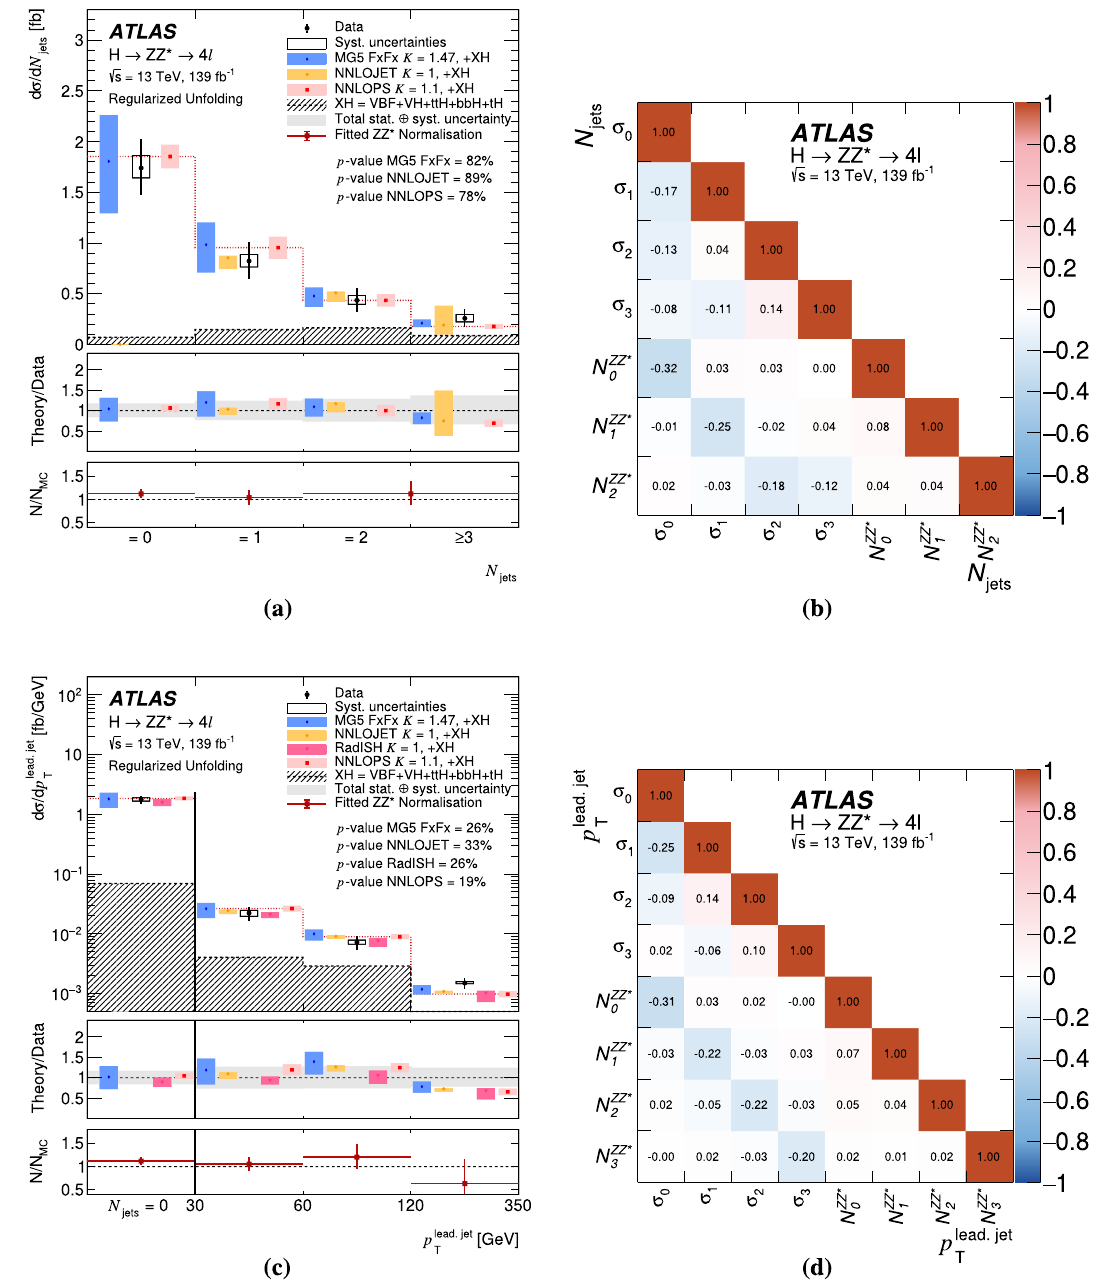
Fig. 42 a , c Differential fiducial cross sections as a function of the jet multiplicity, N jets , and leading jet p T in events with at least one jet, using a regularised matrix unfolding with the τ parameters set to 0.6 predictions are close to the ones obtained with the matrix unfolding without any